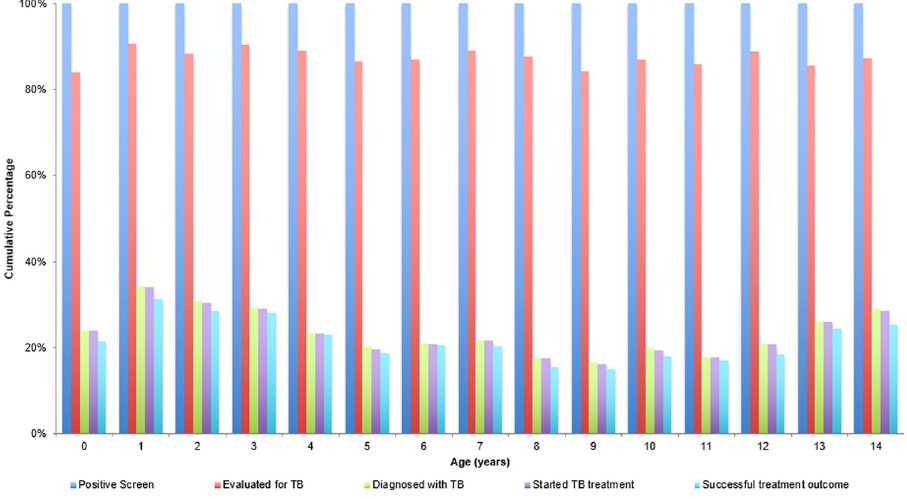
Fig 4. Cumulative percentages of all children with a positive screen completing each step of care cascade, by age.